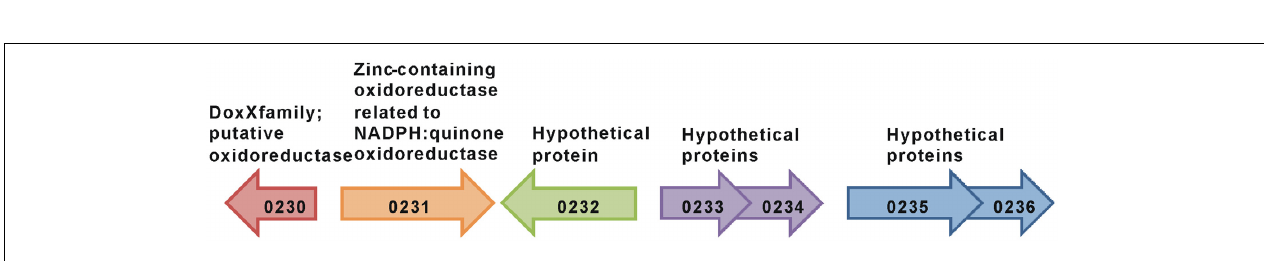
[ 14 C]benzene or (B) [ 14 C]phenol. The results are the mean and standard deviation for triplicate cell suspensions.